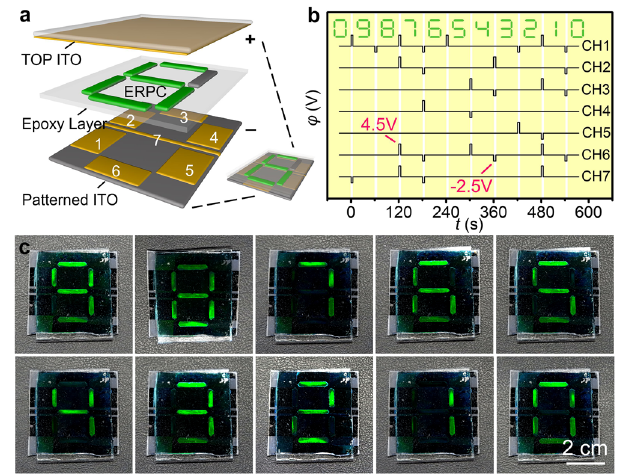
Fig. 5 | Numerical indicator based on bistable ERPC. a schematic diagram of the numerical indicator composed of seven parts of independently controlled SiO 2 / PCb-PEG-EG ERPC (30/60/5/5vol%); b the voltage pro fi les of Channel 1 – 7 for the sequent display of ten digits; c displaying the digits from 9 to 0 in the absence of E- fi